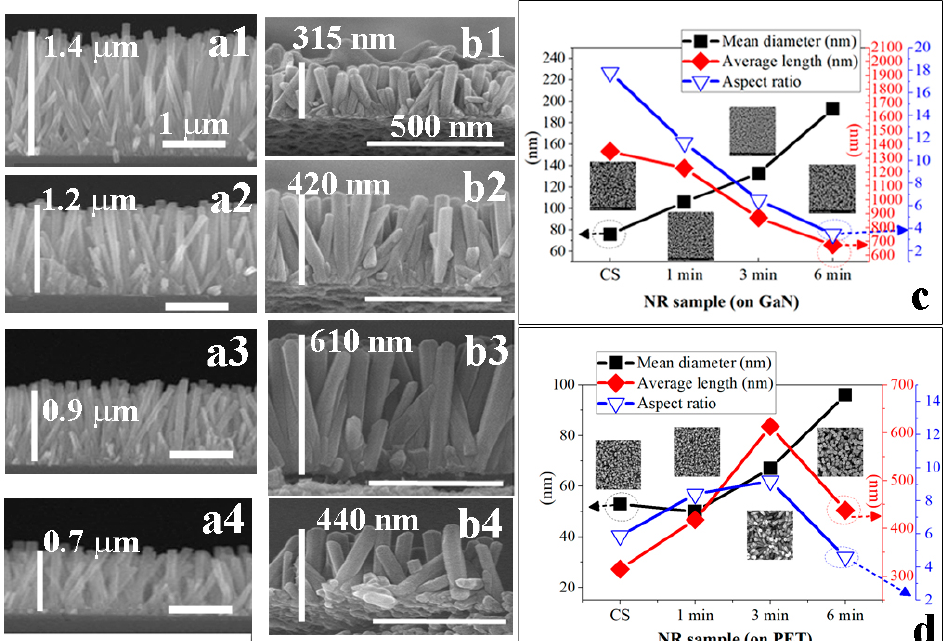
Figure 4. Cross-sectional SEM micrographs of the ZnO NRs grown with untreated SLs (CS, control sample) and the SLs N 2 O plasma-treated for 1, 3, and 6 min in the cases of growths on (( a1 ) CS, ( a2 ) 1 min, ( a3 ) 3 min, ( a4 ) 6 min) the GaN and (( b1 ) CS, ( b2 ) 1 min, ( b3 ) 3 min, ( b4 ) 6 min) PET substrates. Summary of mean diameters, average lengths, and aspect ratios (length/diameter) of ZnO NRs grown under different SL treatment conditions on ( c ) the GaN and ( d ) PET substrates.